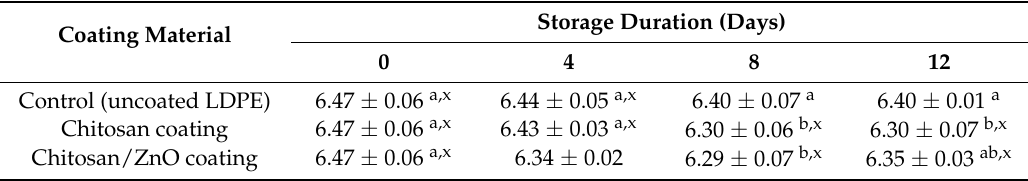
Table 1. Effect of different coatings on pH of okra samples at each storage